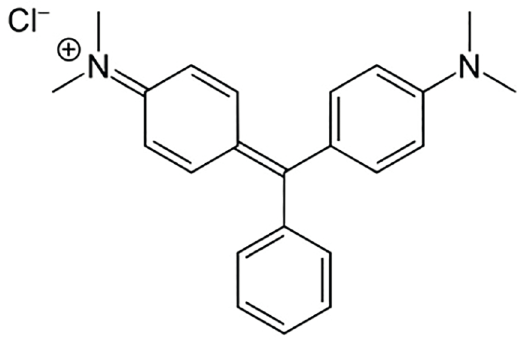
Figure 1. Chemical structure of MG